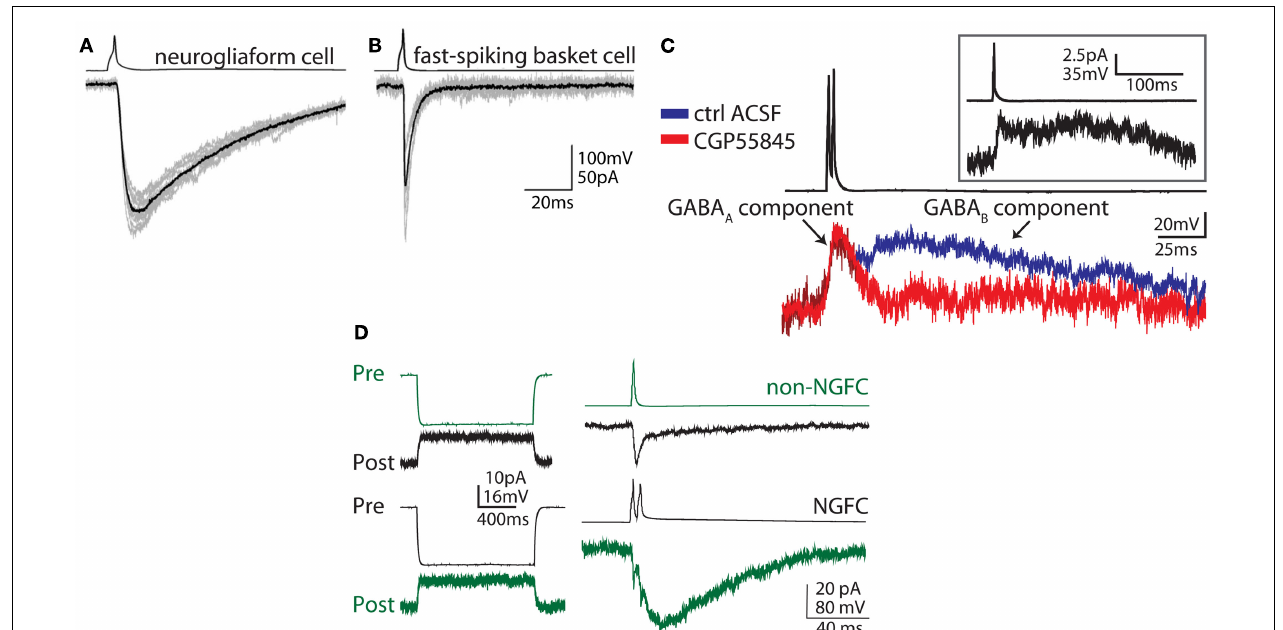
NGFC (black traces) and a non-NGFC (green traces) can be appreciated (example from dentate gyrus). Left traces : a hyperpolarizing current step (Pre, current clamp responses shown in the upper traces of each example), evokes an outward current in the electrically connected cell (Post, voltage clamp responses shown in the lower traces of each example). Right :When an action potential is evoked in the presynaptic non-NGFC, only a short inward current, due to electrical coupling, is observed in the connected NGFC, while both electrical and chemical synaptic responses can be appreciated in the postsynaptic non-NGFC in response to NGFC stimulation (upper traces, both pre and postsynaptic traces are averaged). Note the electrical responses in the non-NGFC riding on top of the slow GABA-mediated IPSC. Reproduced and modified with permission from Szabadics et al. (2007) (A,B) and Armstrong et al. (2011) (C,D)